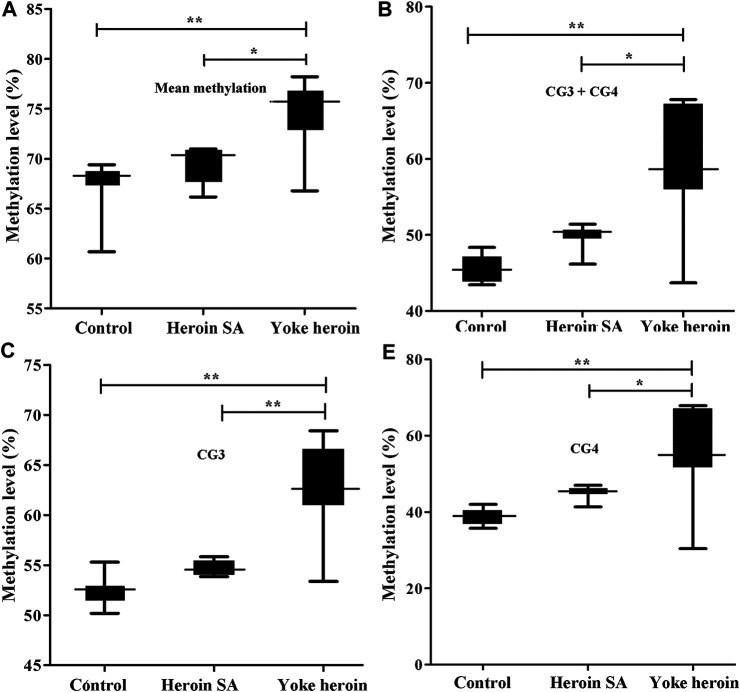
Comparisons of GABRP methylation levels among the three groups (n = 10 per group). SA: Self-administration. The methylation levels were calculated and the statistical differences evaluated by one-way ANOVA followed by Student–Newman–Keuls post hoc comparisons. Data were presented as means ± SDs. *p < 0.05; **p < 0.001.